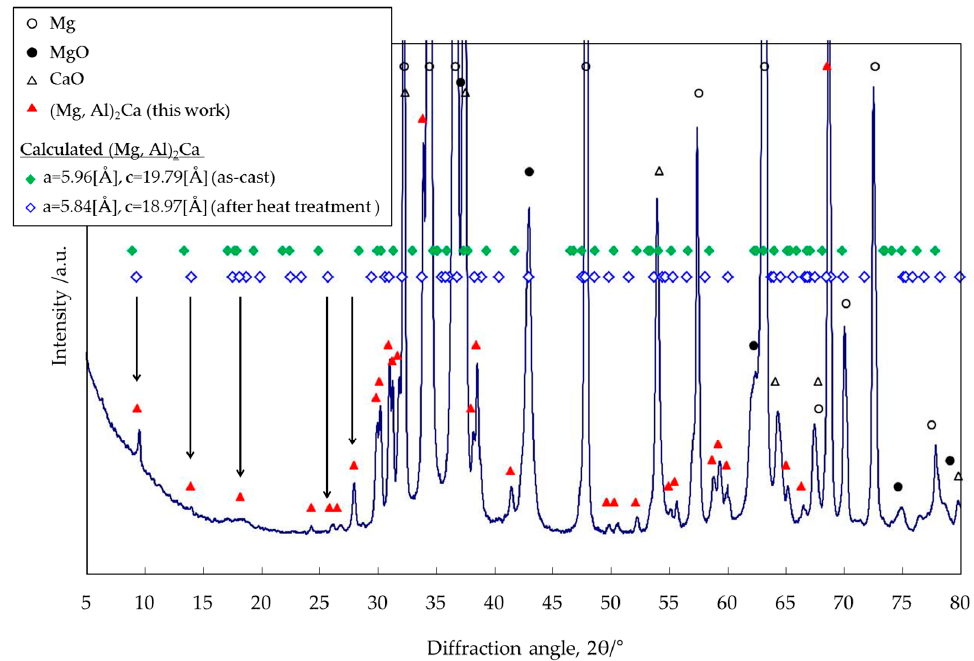
Figure 11. X-ray diffraction pattern of the Mg–Al–CaO precursor with 10-vol % CaO particles after the heat treatment at 500 °C for 300 s.